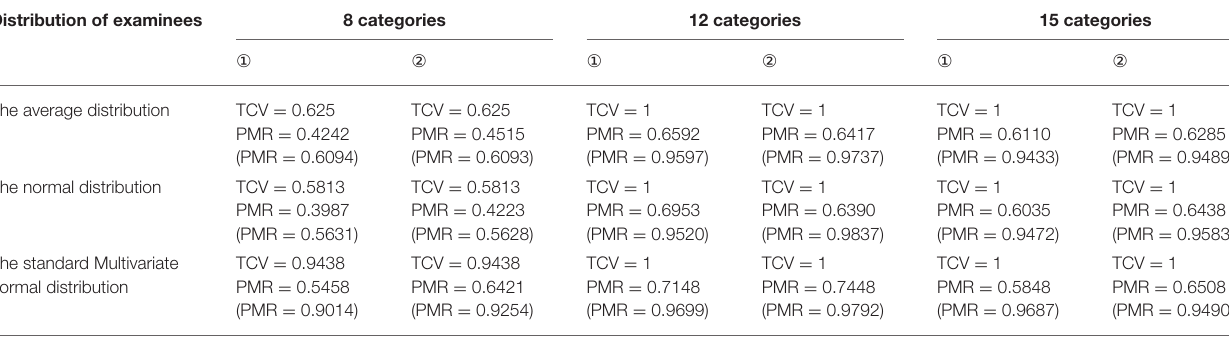
TABLE 7 | The comparison between the TCV and the PMR ORP of the independent